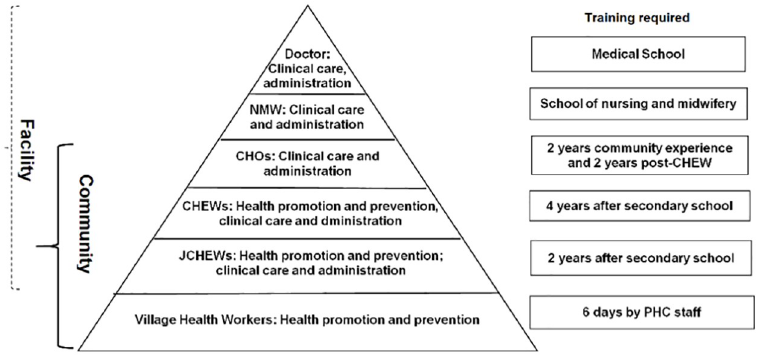
Fig 2. Roles of the different cadres of PHC staff